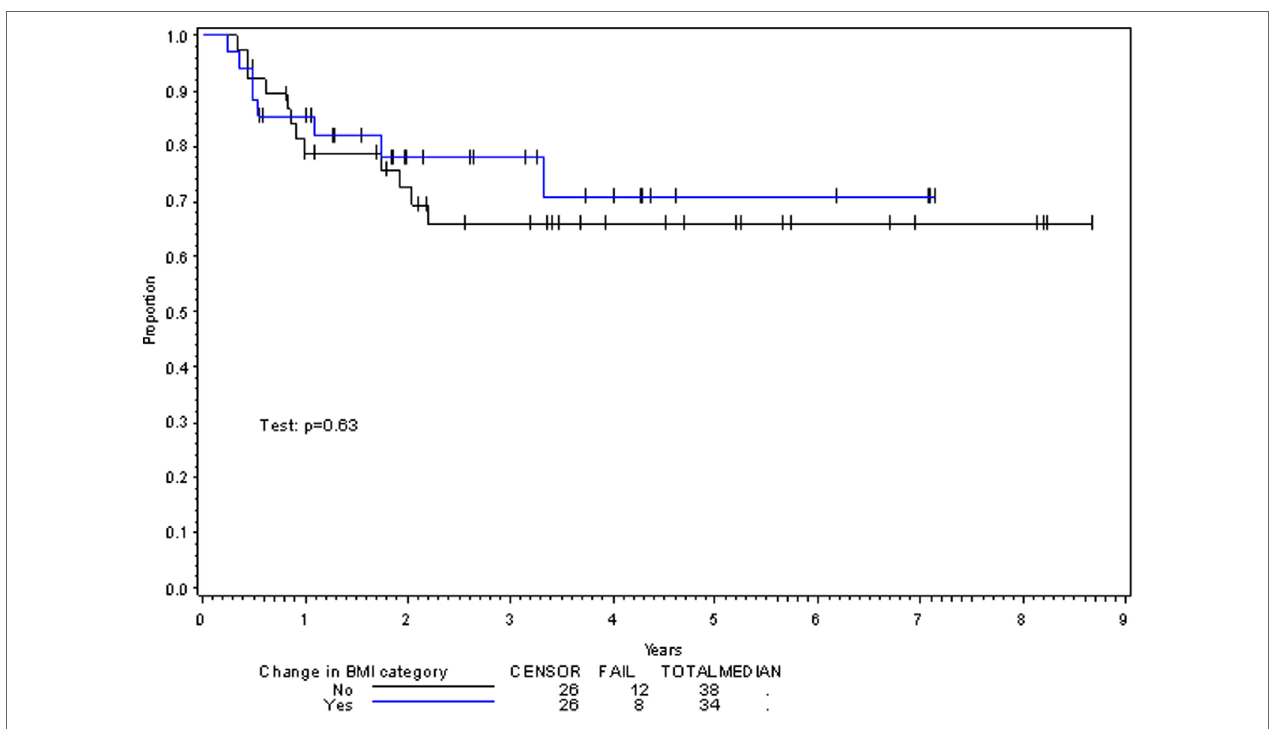
FigUre 2 | Disease-free survival per change in BMI category with treatment.